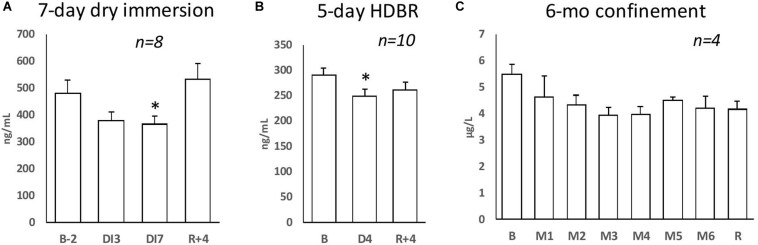
Plasma level of sCD146 during (A) 7-day dry immersion and (B) 5-day HDBR. (C) Serum level of sCD146 during 6-month confinement. Data are mean ± SEM; *p < 0.05 vs B.